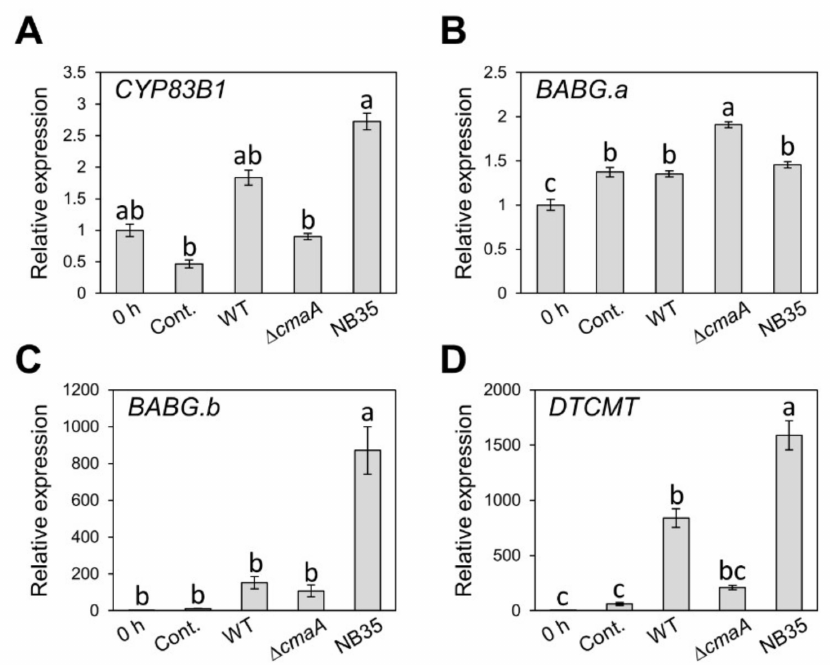
Figure 5. Gene expression profiles of brassinin biosynthesis-related genes after syringe inoculation with water (mock), or Pseudomonas cannabina pv. alisalensis KB211 WT, ∆ cmaA , and NB35 (TTSS mu- tant). Expression profiles of CYP83B1 ( A ), BABG.a ( B ), BABG.b ( C ), and DTCMT ( D ) were determined 6 h after inoculation with 5 × 10 7 CFU/mL of WT, ∆ cmaA , NB35 or mock water-inoculated control, using real-time quantitative reverse transcription PCR with gene-specific primer sets. Expression in cabbage was normalized using BoUBQ1 . Vertical bars indicate the standard error for three biological replicates. Different letters indicate a significant difference among treatments based on a Tukey’s honestly significant different test ( p <